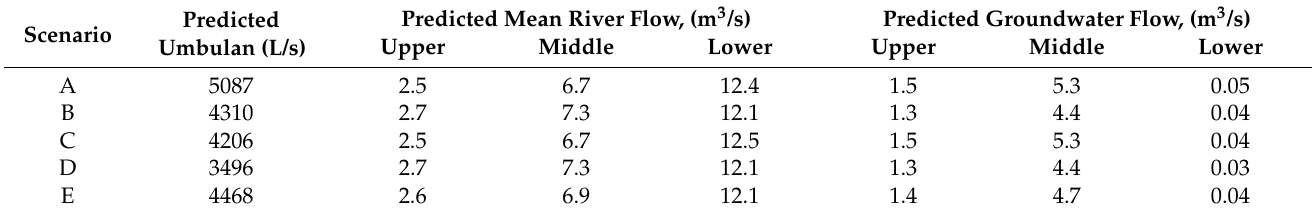
Table 3. Predicted discharge of the Umbulan spring, river and groundwater flow for five land use scenarios: A) a historical reference scenario, B) upland degradation, C) lowland conversion to paddy with uncontrolled artesian wells, D) combining the changes of B + C, and E) a restoration scenario with agroforestry in upper and middle zones and reduced groundwater use in the lowland paddy